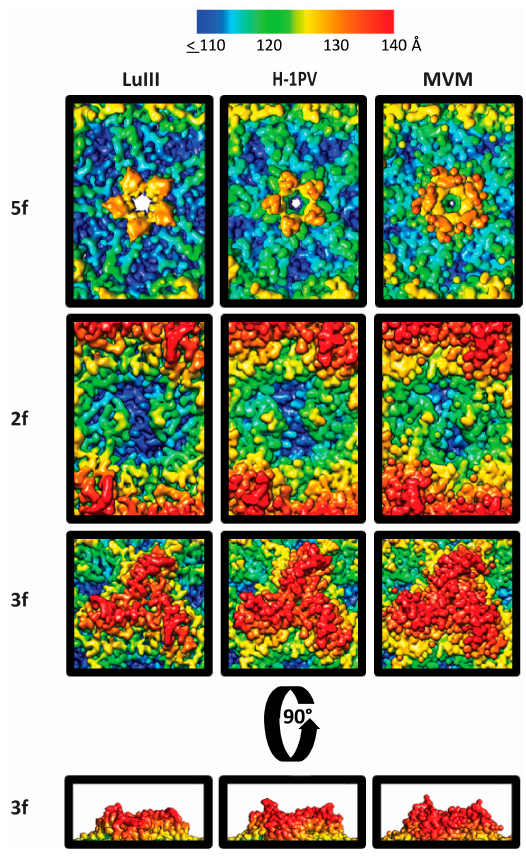
Figure 5. Comparison of surface topology among the rodent protoparvoviruses. Radially colored surface images for the rodent protoparvoviruses (see color key in Å), with close ups of the icosahedral 5-fold, 2-fold, and 3-fold symmetry axes at the top, middle, and bottom, respectively. A 90° rotation is also shown for the 3-fold protrusions. LuIII has an open 5-fold channel surrounded by a depression that is wider, an expanded 2-fold depression, and less pronounced 3f protrusion. The LuIII structure was compared to molecular maps of H-1PV (PDB ID: 4g0r) and MVM (PDB ID: 1z14) docked into the cryo-reconstructed LuIII density map, and filtered to 3.17 Å resolution.